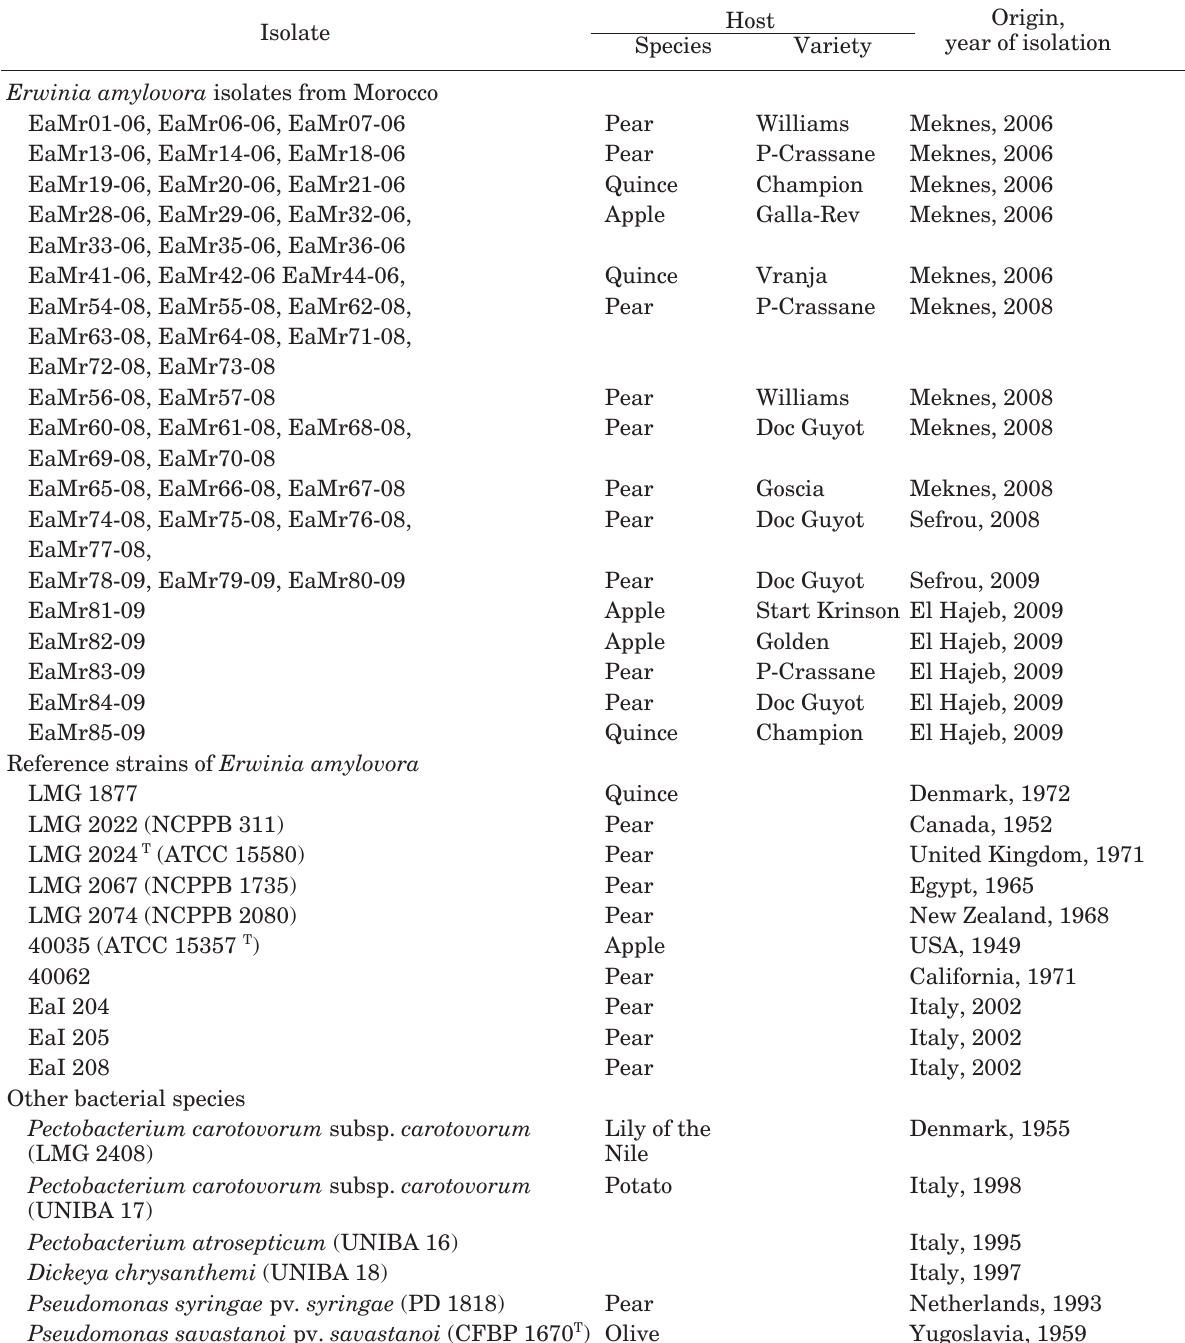
Host Origin, year of isolationSpecies Variety